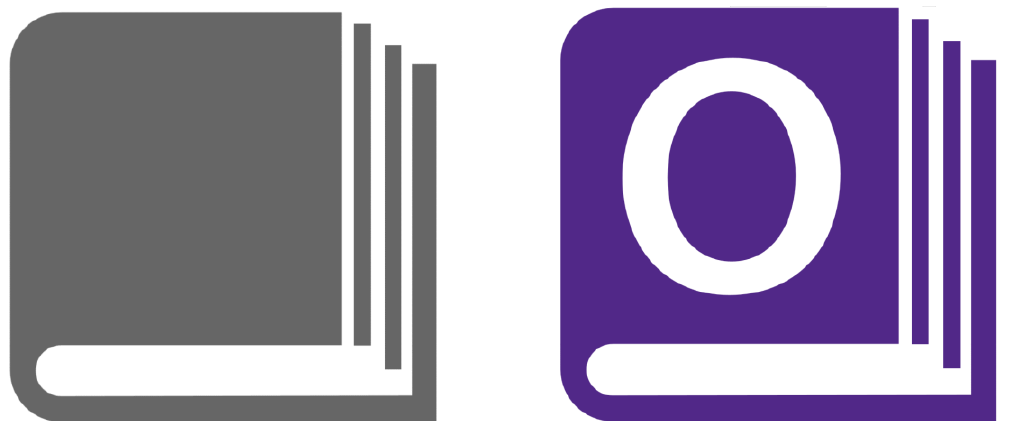
Figure 1. Regular Book Icon (left) and Open/Alternative Textbook Icon